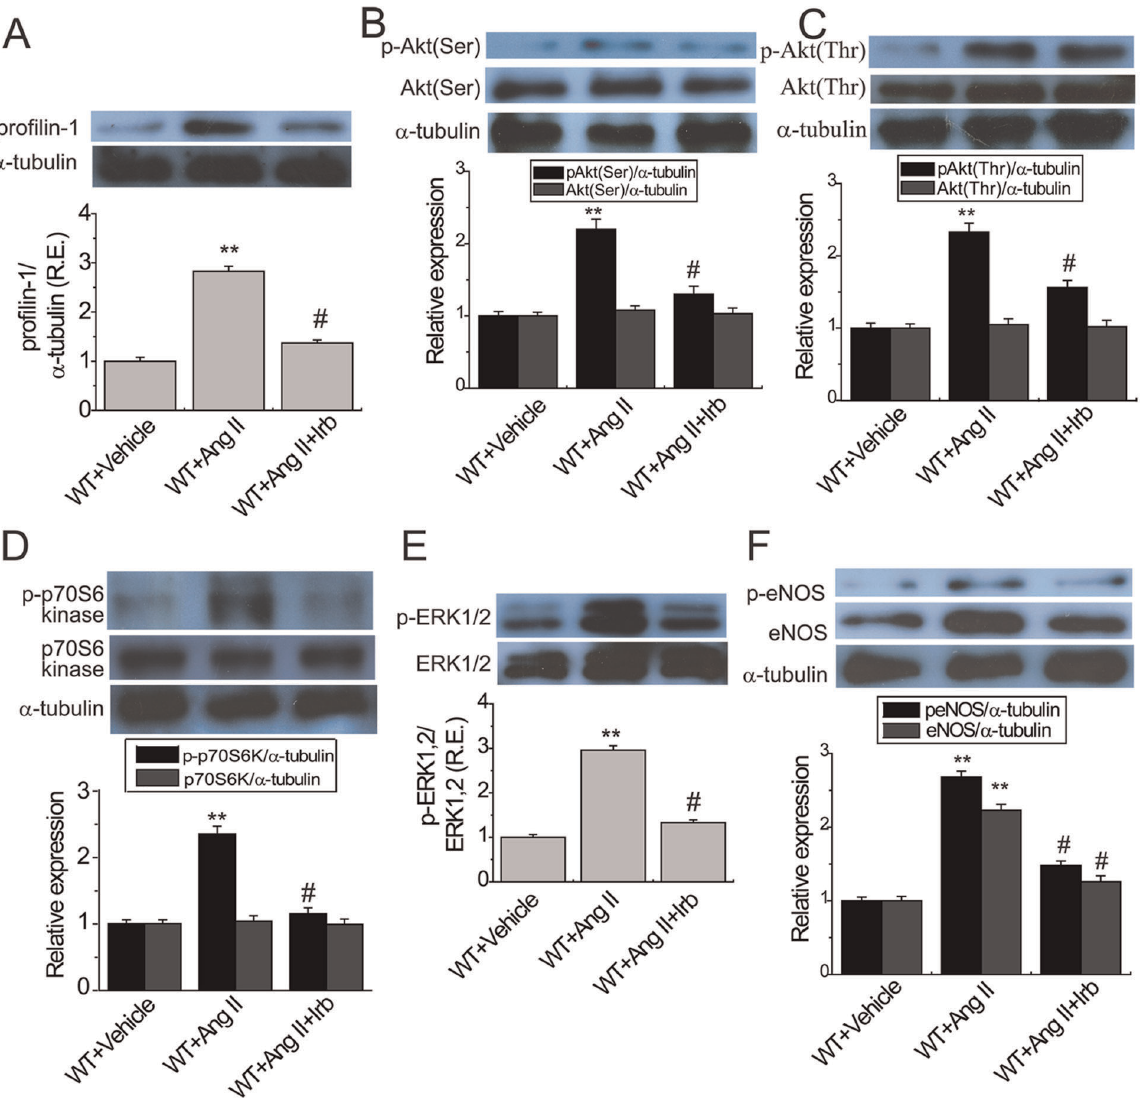
Figure 5. Aortic profilin-1 expression and signaling cascades in Ang II-infused mice following irbesartan treatment. Protein level of profilin-1 (A; 15 kD) and phosphorylated levels of Akt at Ser 473 and Thr 308 (B & C; 60 kD), p70S6 kinase (D; 70 kD), ERK1/2 (E; 44/42 kD) and eNOS (F; 140 kD) in aortas of WT mice using Western blot analyses. R.E.=relative expression; Irb, irbesartan; See Figure 2 for other abbreviations. a -tubulin (55 kD) was used as an endogenous control. n=5. ** P , 0.01 compared with WT + vehicle group; # , P , 0.05 compared with WT + Ang II